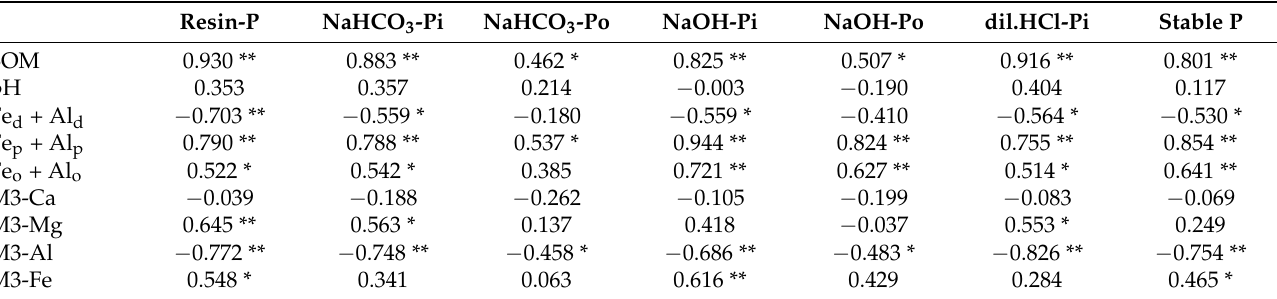
Table A2. Correlation between soil properties and P